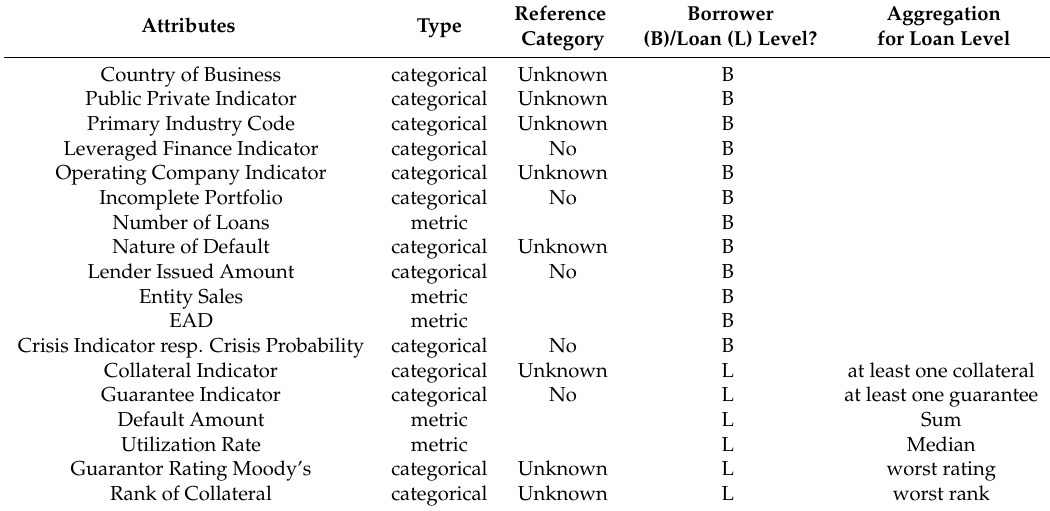
Table A1. Attributes of the